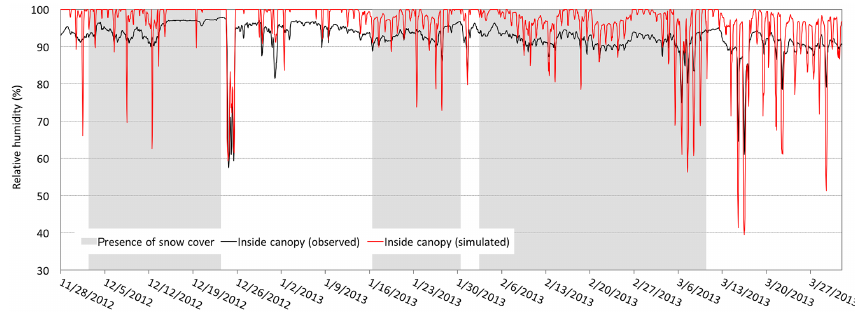
Figure 8. Simulated and observed relative humidity inside the forest canopy for the winter period 2012/13 at site Vordersteinwald. The grey areas indicate periods with presence of a snow cover.